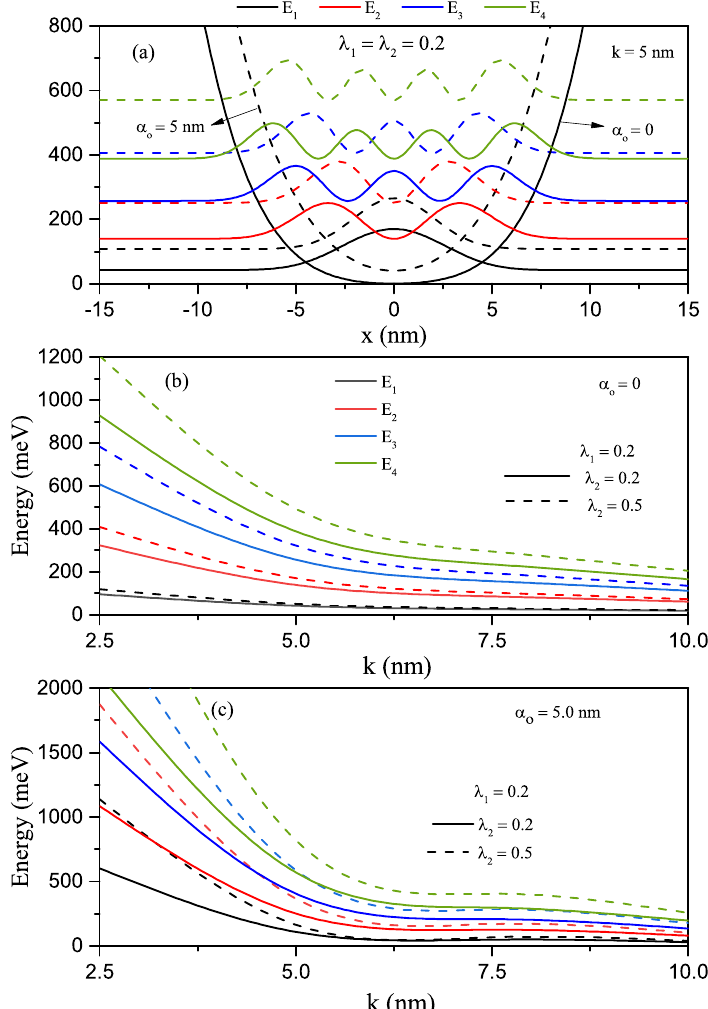
Figure 4. The quartic single AHO potential and squared wave functions of the first four levels in relevant energy values versus the x -coordinate for k = 5 nm and λ 1 = λ 2 = 0.5 ( a ). Results are for α 0 = 0 (solid lines) and α 0 = 5 nm (dashed lines). In the absence of ILF, the variations of the first four level energies as a functions of the width k -parameter for a constant λ 1 value and two different λ 2 values ( b ). In the presence of ILF, the variations of the first four level energies as a functions of the width k -parameter for a constant λ 1 value and two different λ 2 values ( c